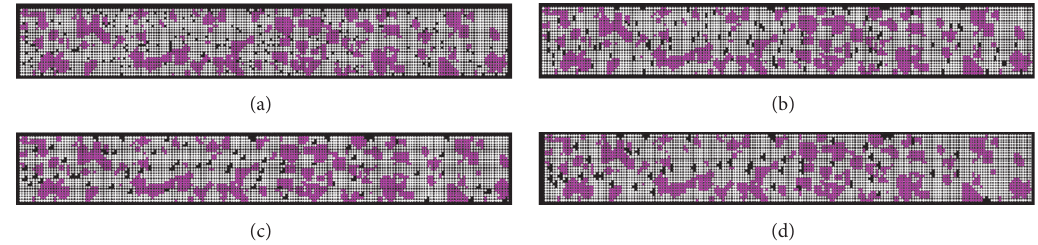
Figure 13: Samples with different sizes of air voids: (a) Size 1; (b) Size 2; (c) Size 3; (d) Size